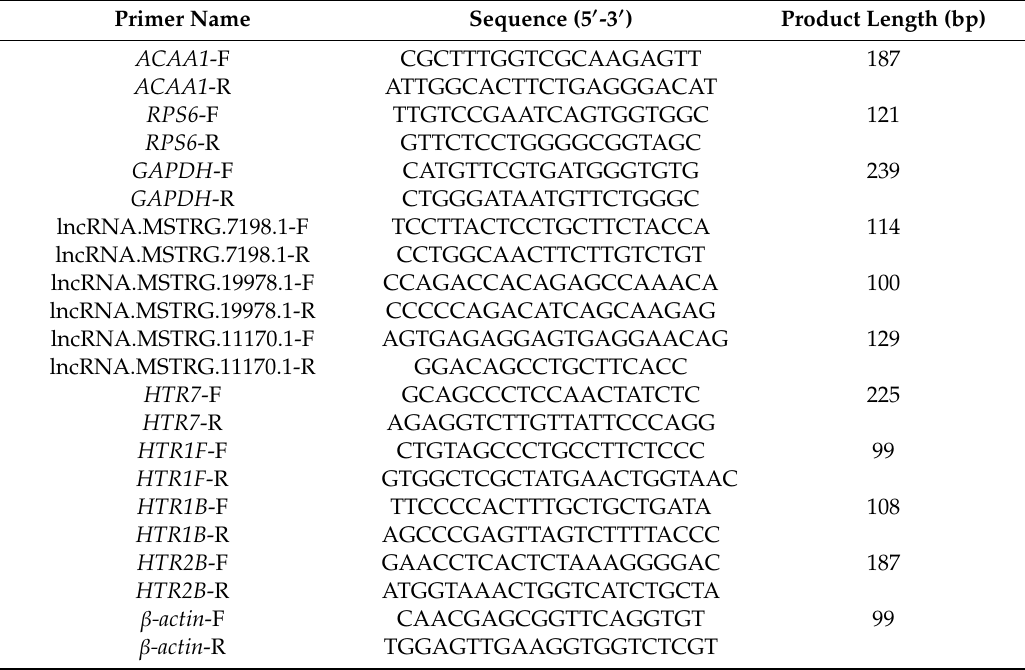
Table 2. PCR primers used in this